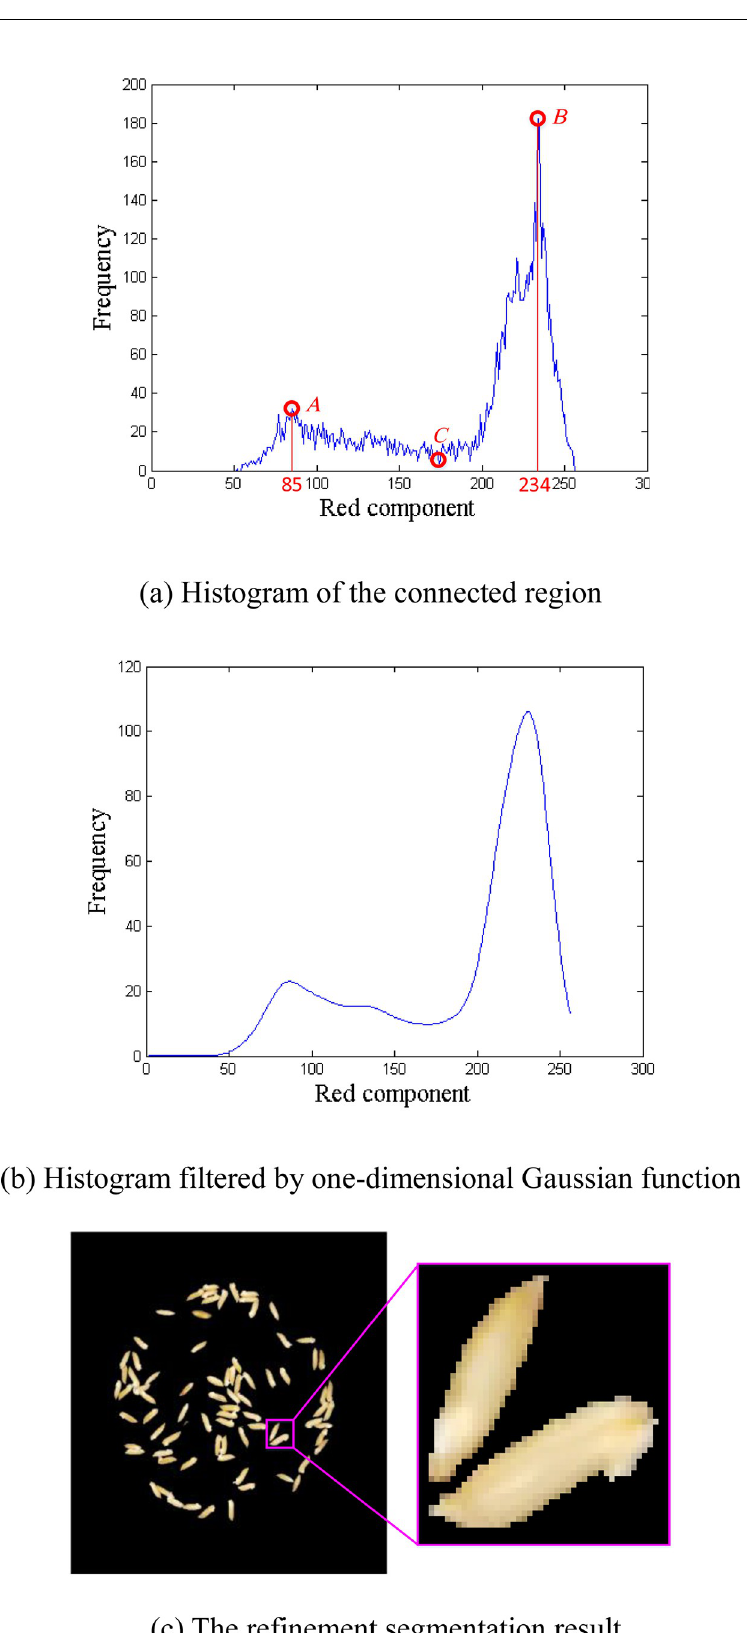
Fig 4. Refinement